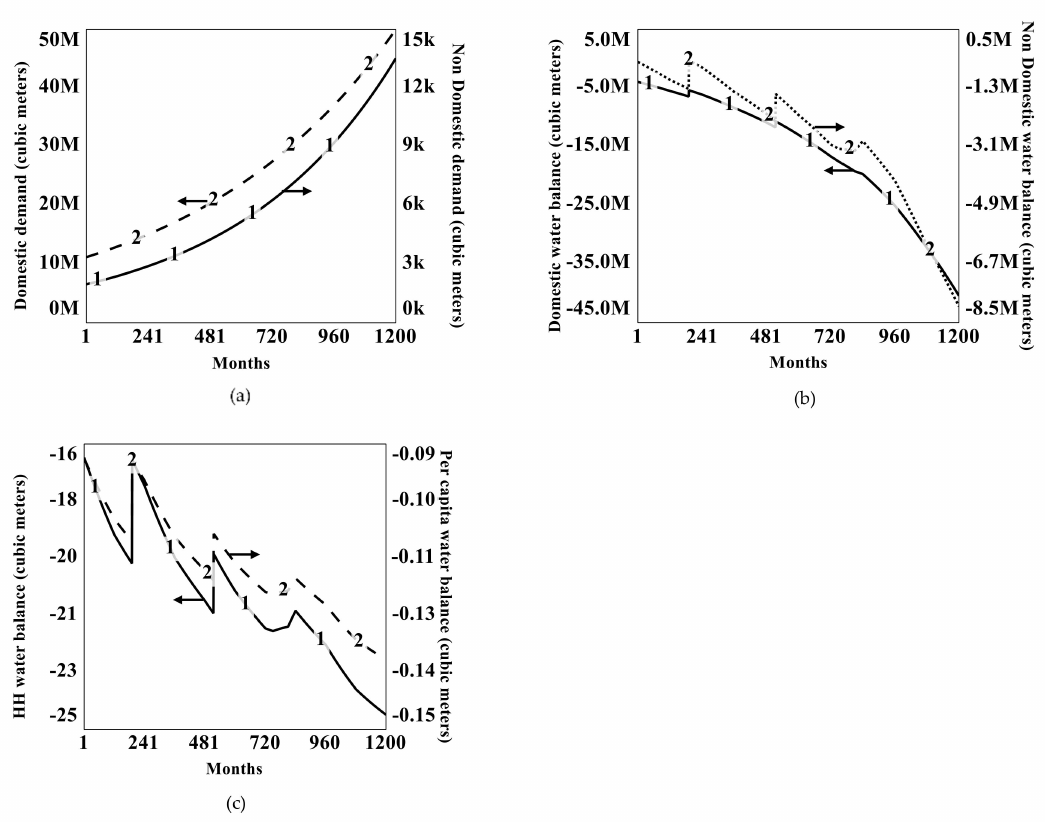
Figure2. ( a )Totaldomesticandnon-domesticurbanwaterdemand, ( b )totaldomesticandnon-domestic urban water balance and ( c ) water balance at HH and per capita level (increased formal supply capacity of 25MGD and 26 MGD in t = 192 (2023) and t = 516 (2050) decreased the